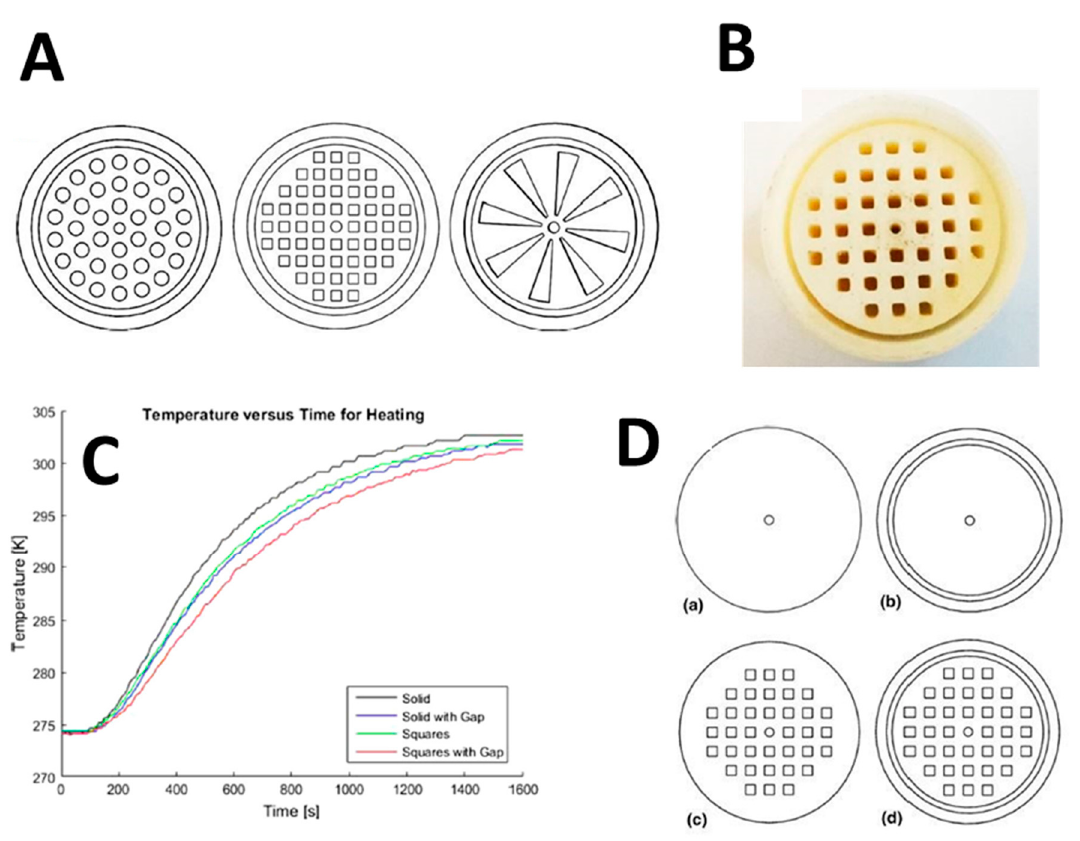
Figure 23. ( A ) Circular, square and biomimetic internal structure proposals. ( B ) Square-hole monolith with 35 mm diameter. ( C ) Heating of acrylonitrile butadiene styrene (ABS) catalyst substrates. ( D ) Different cross-sectional design for channels with substrate: (a) solid; (b) solid with gap; (c) squares; (d) squares with gap. Reproduced with permission from [119]. Copyright Nature, 2017.